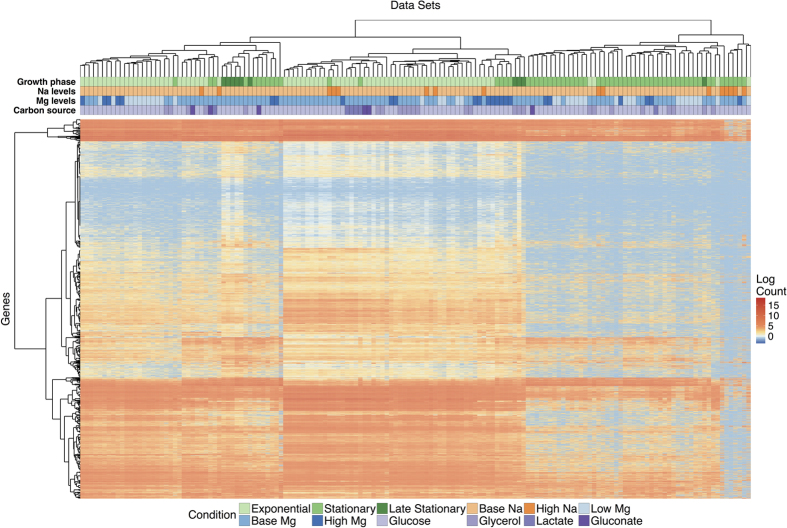
Clustering of mRNA abundances.The heatmap shows 4196 mRNA abundances for each of 152 samples, clustered both by similarity across genes and by similarity across samples. The growth conditions for each sample are indicated by the color coding along the top of the heatmap; the color coding is defined in the legend at the bottom.